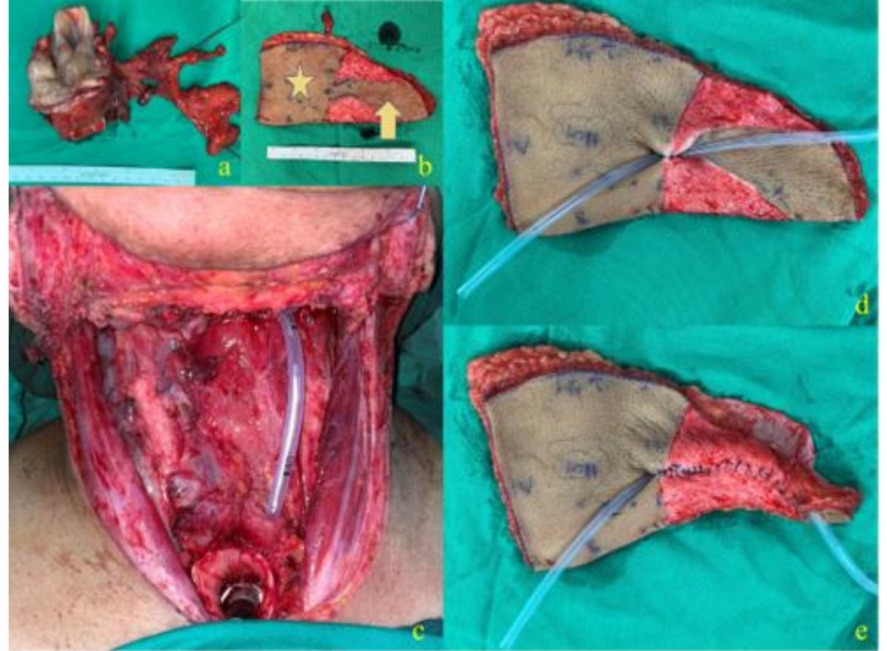
Figure 1. Demonstration of the design of the J-flap: ( a ) the excised tumor specimen; ( b ) proximal part of the J-flap (star), and distal part of the J-flap (arrow); ( c ) the tracheoesophageal defect; ( d , e ) creation of the phonation tube.